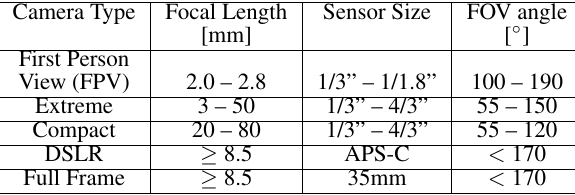
Table 1: Existing vision